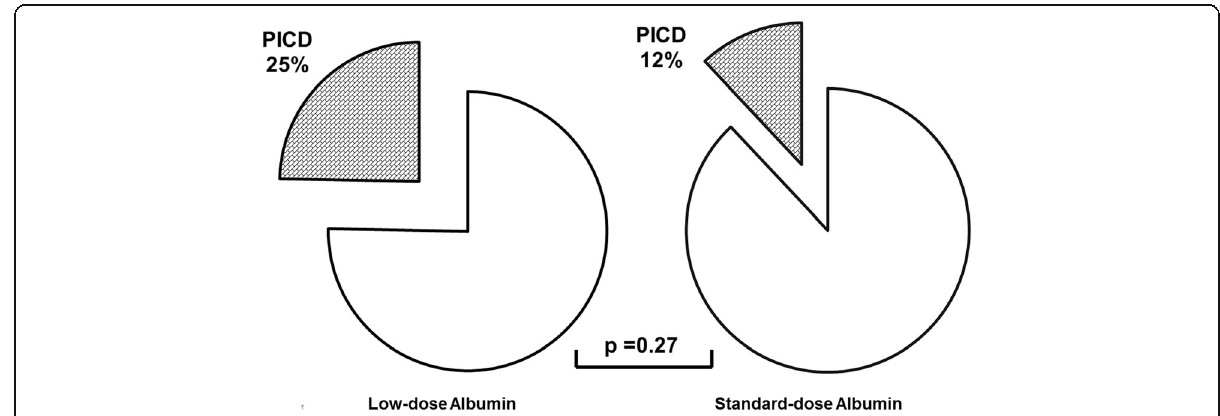
Fig. 2 Incidence of paracentesis circulatory dysfunction (PICD) in low- and standard-dose albumin